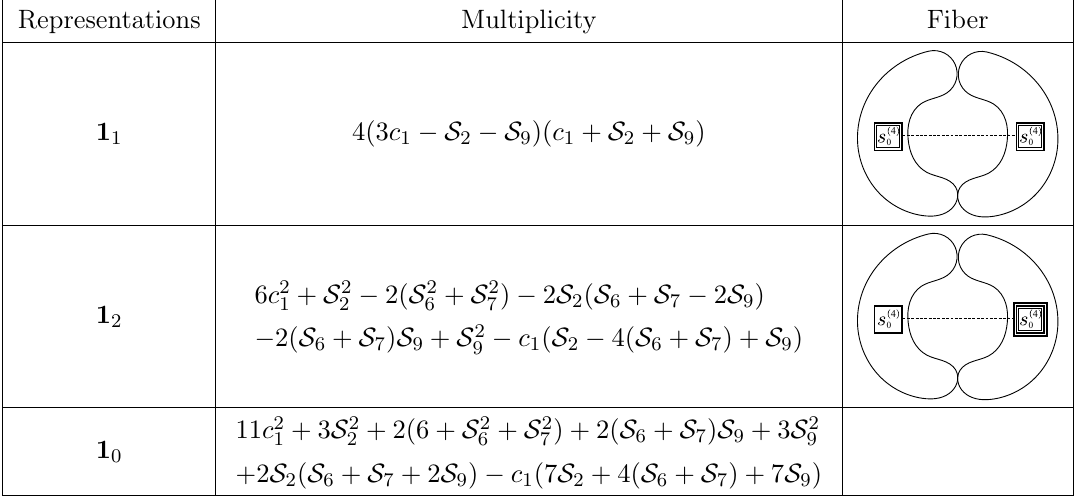
Table 3 . Summary of the charged matter representations and multiplicities under Z 4 and codi- mension two fibers of nef (0 ; 0)